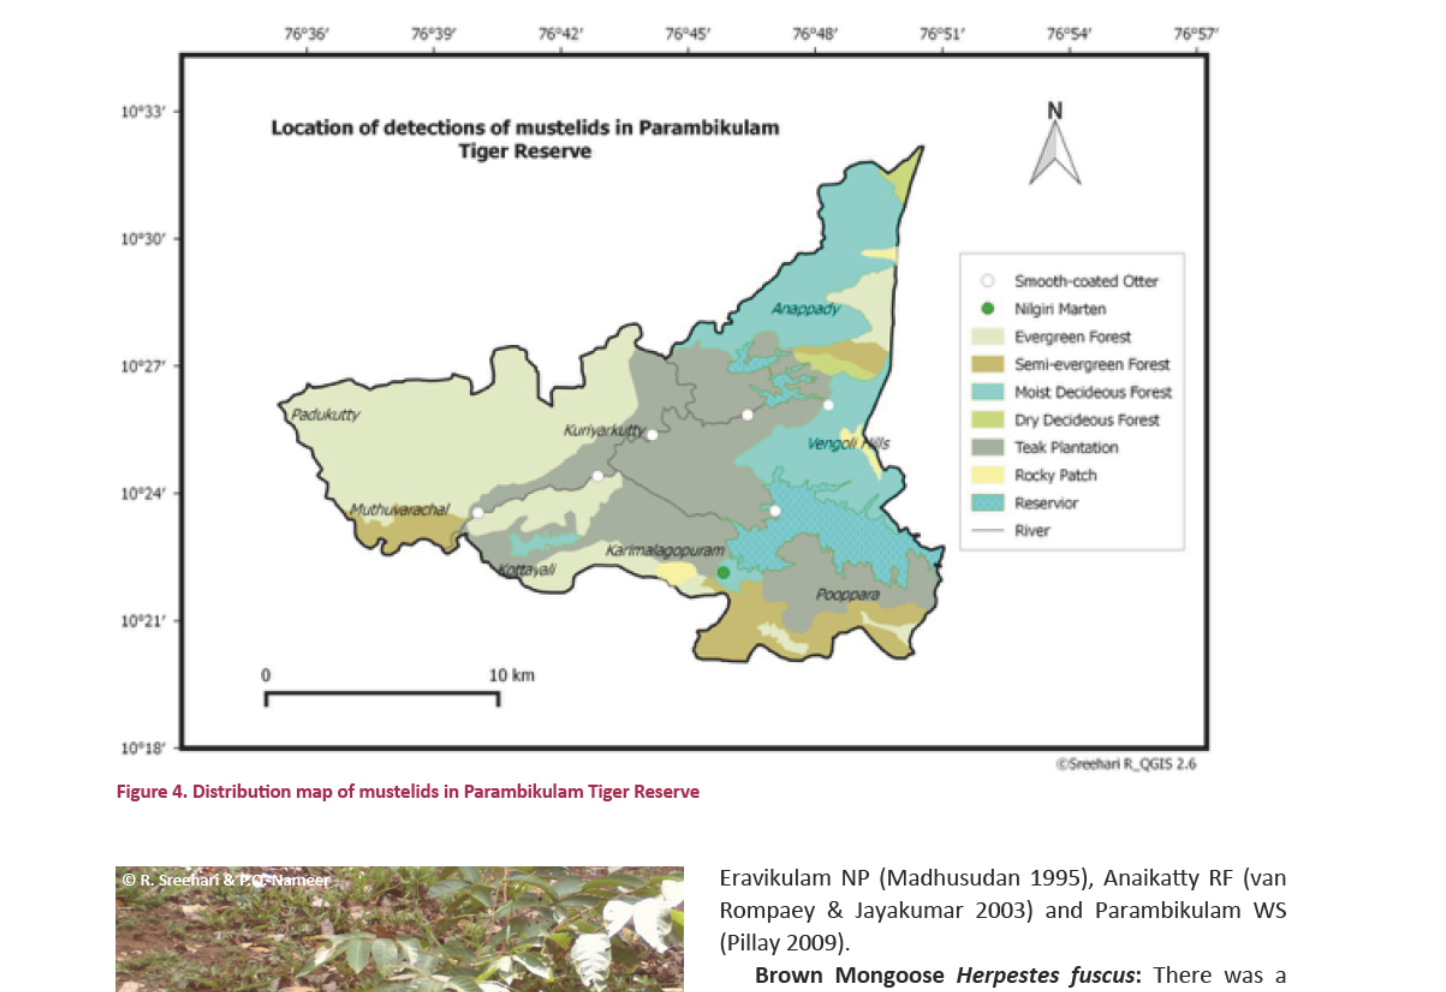
Ffigure 4. Dfistrfibufion map off mustelfids fin Parambfikulam Tfiger Reserve